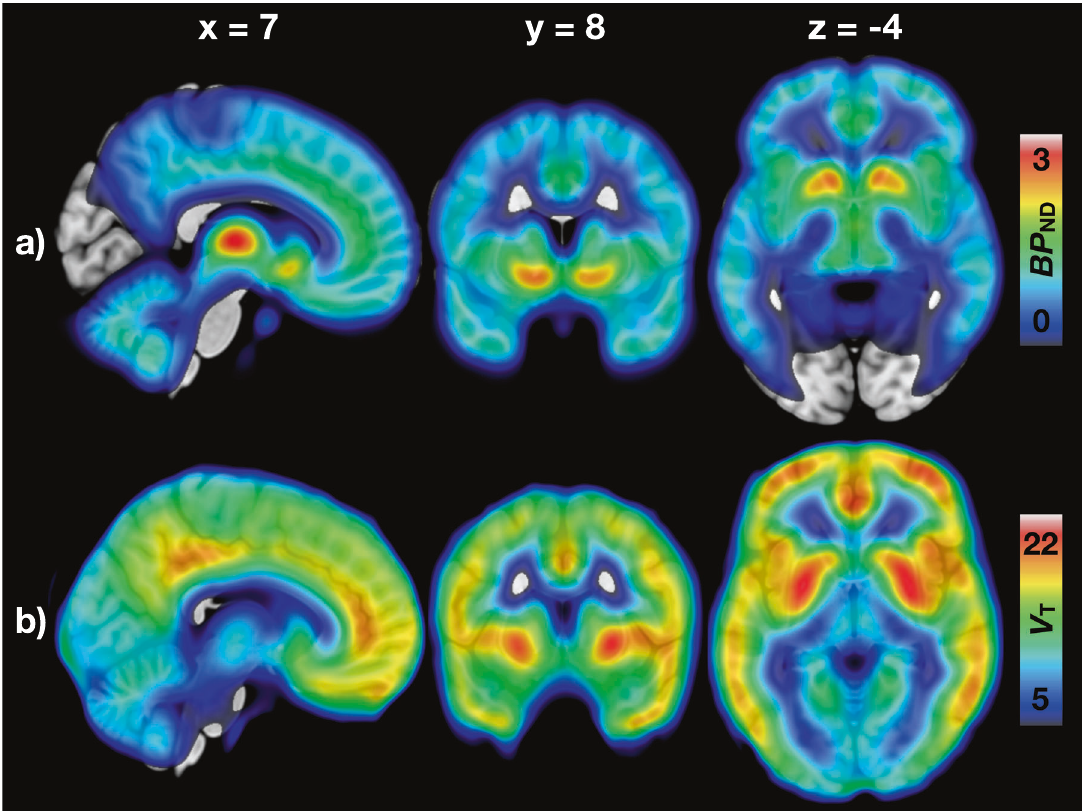
Fig. 1 Mean distribution of central μ -opioid and CB 1 receptors. a Mean binding potential ( BP ND ) of the 92 subjects (70 males and 22 females) studied with [ 11 C]carfentanil. b Mean volume of distribution ( V T ) of the 35 males studied with [ 18 F]FMPEP- d 2